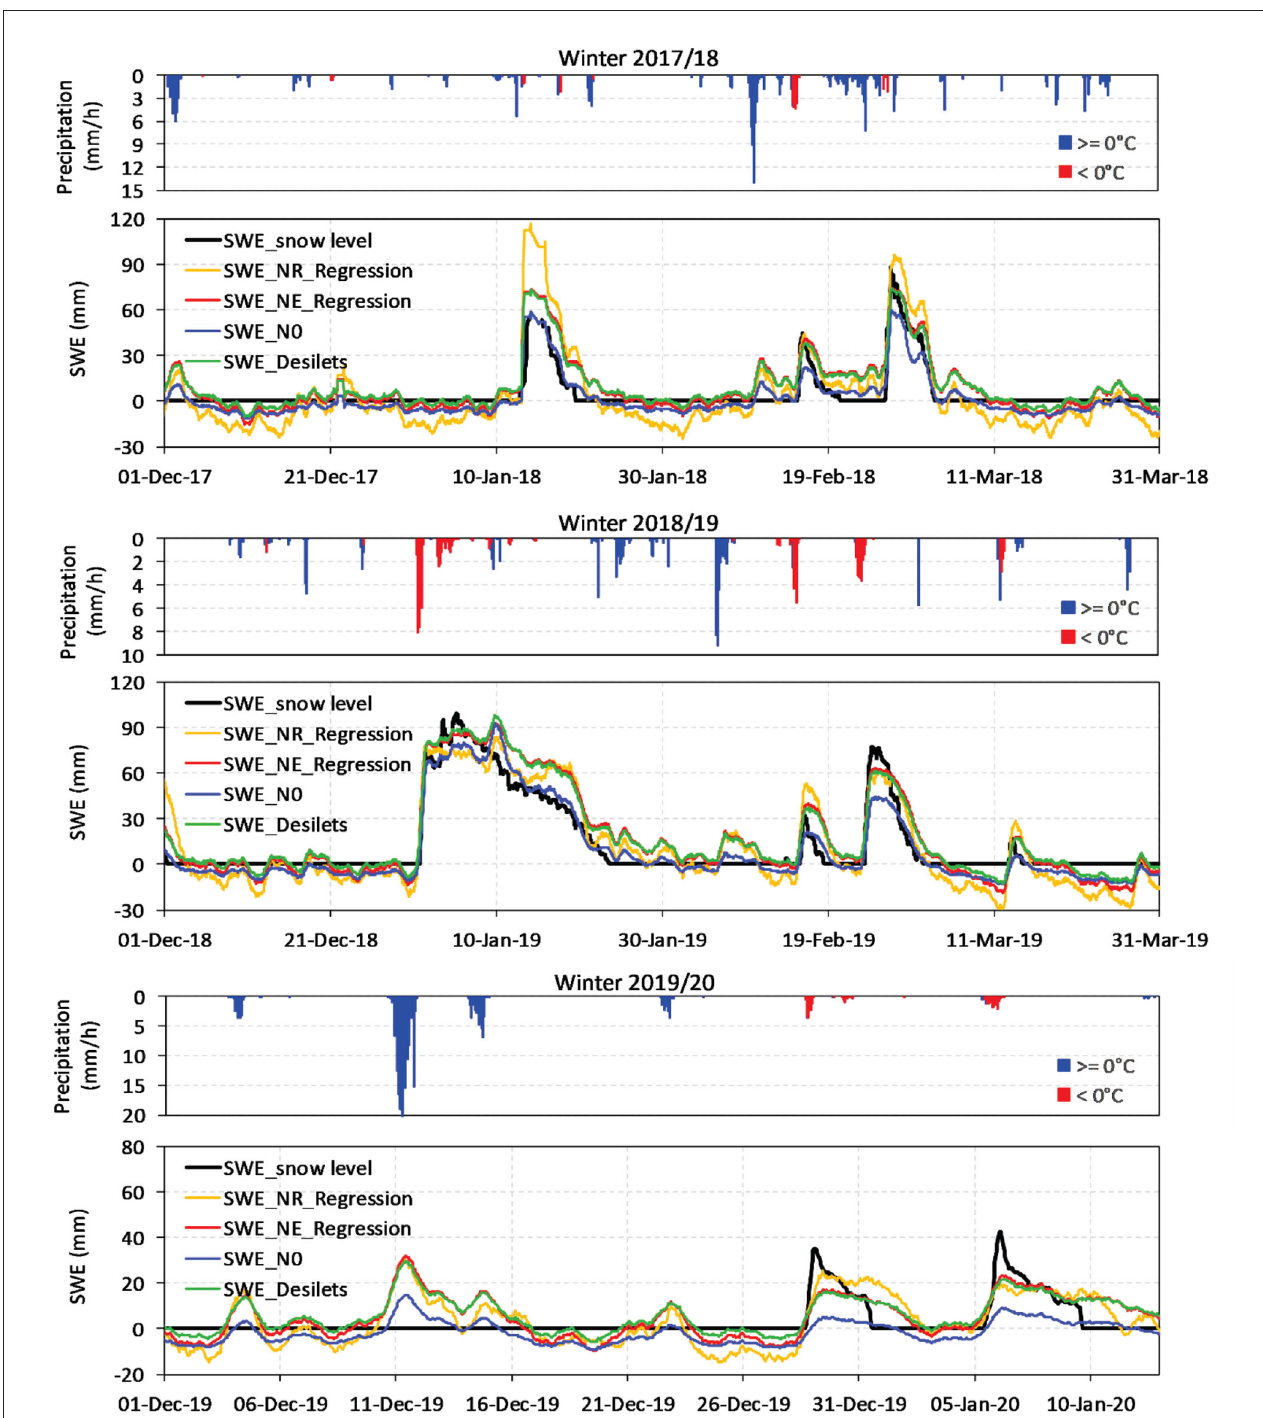
FIGURE 11 | Comparison of the four CRNP-based methods to estimate SWE with the SWE derived from snow level measurements for the winter seasons 2017/18, 2018/19, and 2019/20. Precipitation intensities for freezing and non-freezing conditions are also shown.